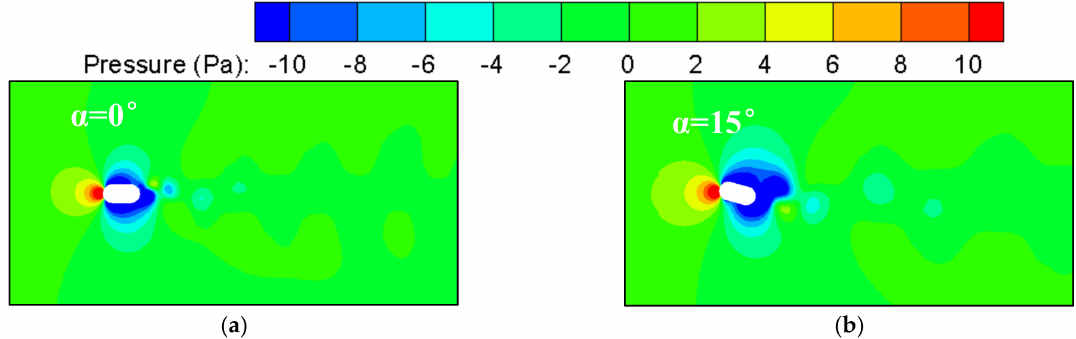
Figure 23. Diagrams of the flow pressure around a round-ended pier: ( a ) α = 0 ◦ ; ( b ) α = 15 ◦ .